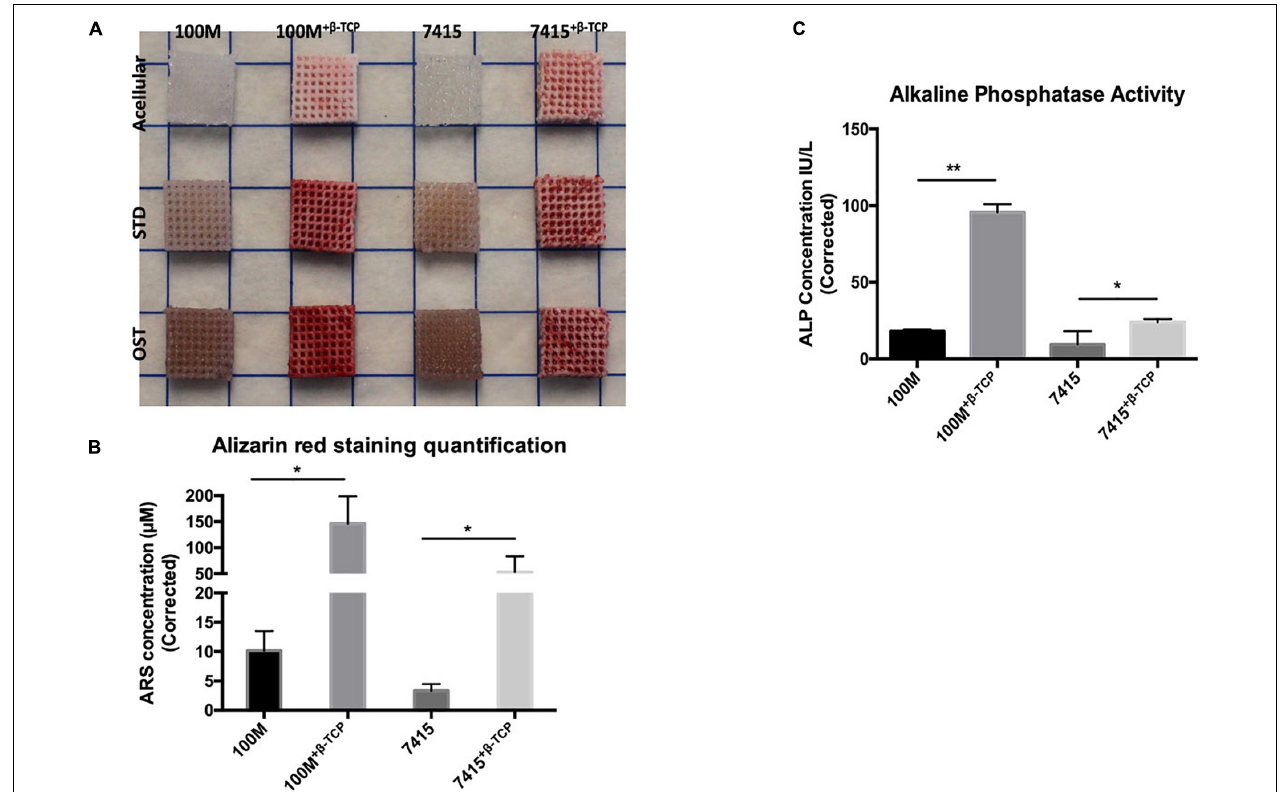
FIGURE 6 | Mineralized matrix deposition. (A) Representative image of fixed scaffolds seeded with BM-MSC stained with Alizarin Red-S stain after 21 days culture ( n = 3 independent experiments). Marker represent 10 × 10 mm squares dimensions. (B) Stain quantification using Alizarin Red osteogenesis kit representing measurements of ARS concentrations of osteogenic culture normalized to standard culture ( n = 3), error bars represent ± SD, and * P -value < 0.05. (C) Alkaline phosphatase activity assay measurements represent ALP concentrations of osteogenic culture normalized to standard culture ( n = 3), error bars represent ± SD, and * P -value < 0.05, ** P -value <